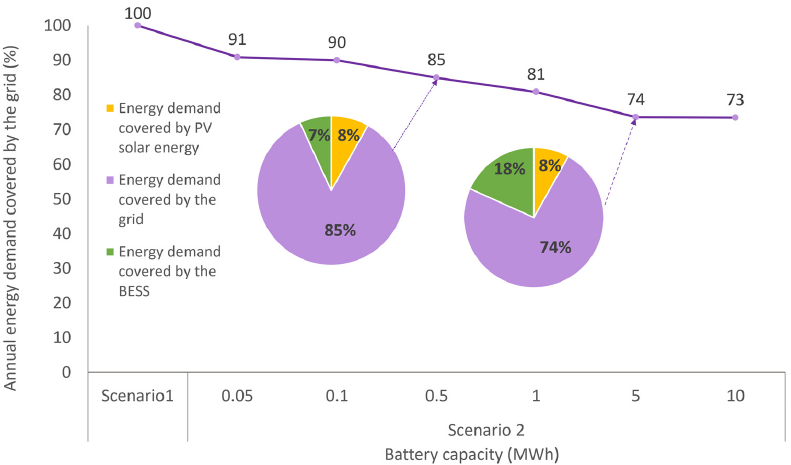
Figure 10. Energy demand covered by the grid for scenario 1 and scenario 2 (purple line), and the breakdown of energy demand covered by the grid, by direct PV generation and by the solar via the BESS for C (cid:2886)(cid:2889)(cid:2903)(cid:2903) of 0.5 MWh and 5 MWh as examples (pie charts).